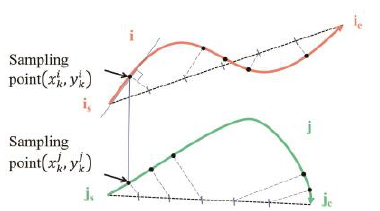
Fig. 3. Second stage grouping.